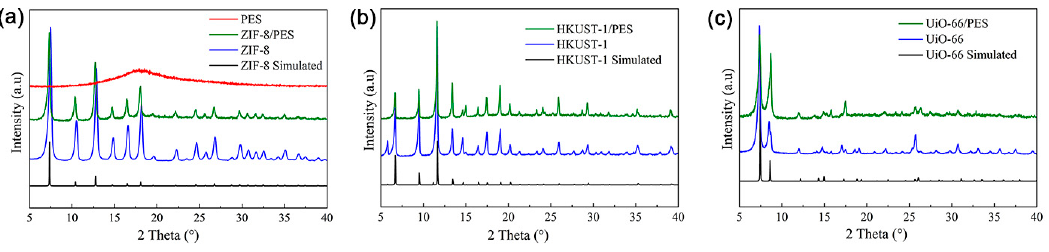
Figure 2. PXRD patterns of MOF, PES and MOF / PES composite materials employing ( a ) ZIF-8, ( b ) HKUST-1, and ( c ) UiO-66.